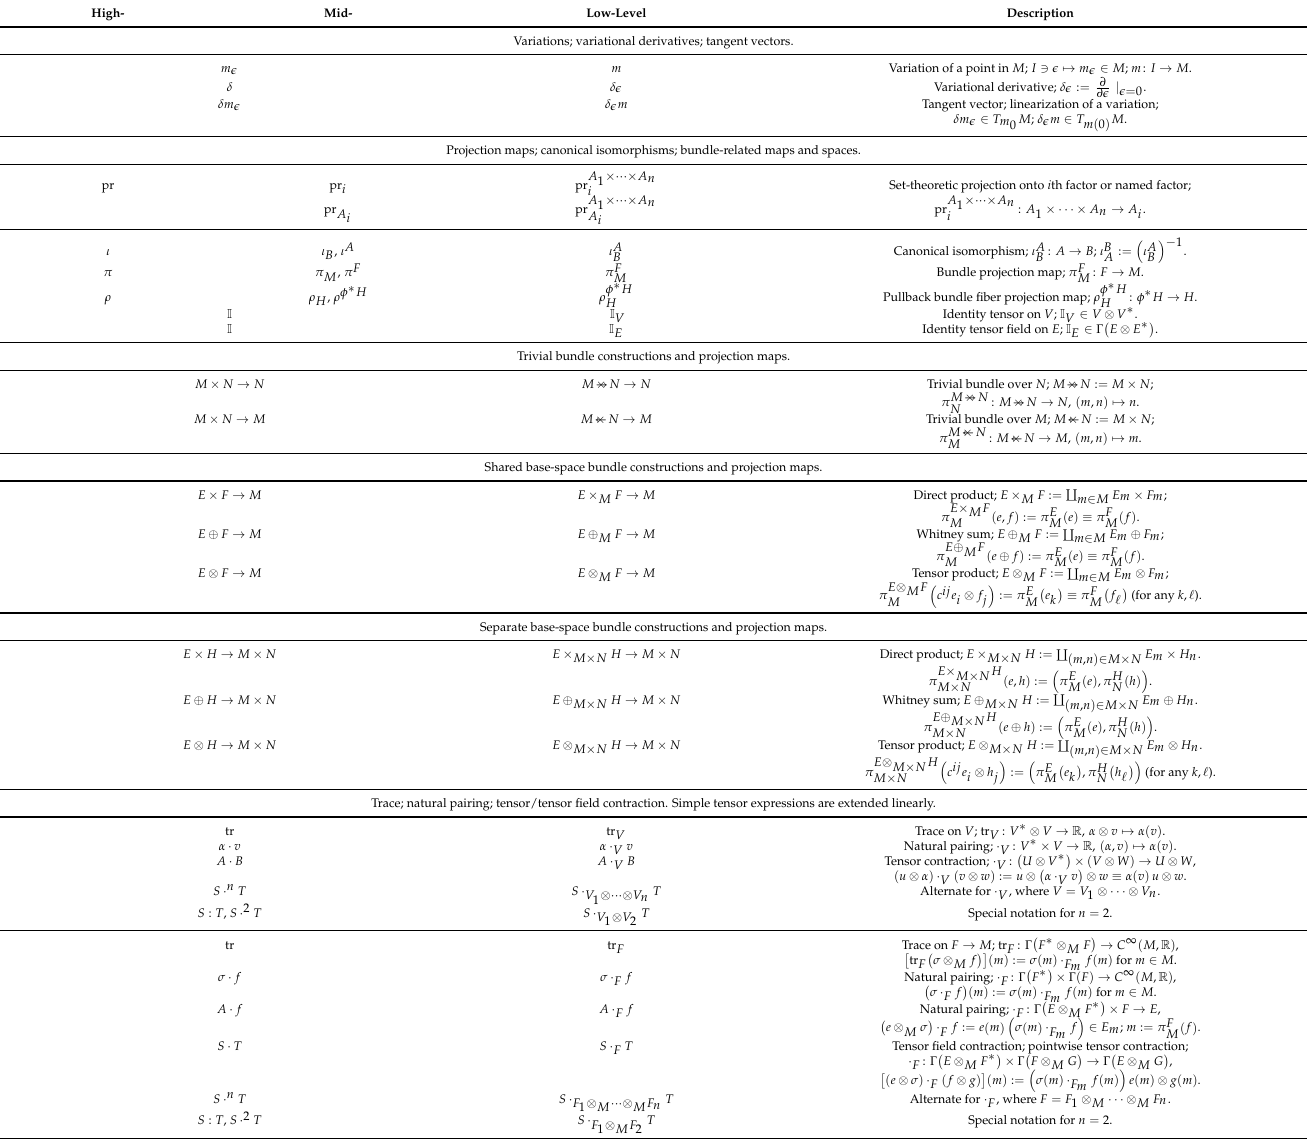
Table 1. Notational Reference Part